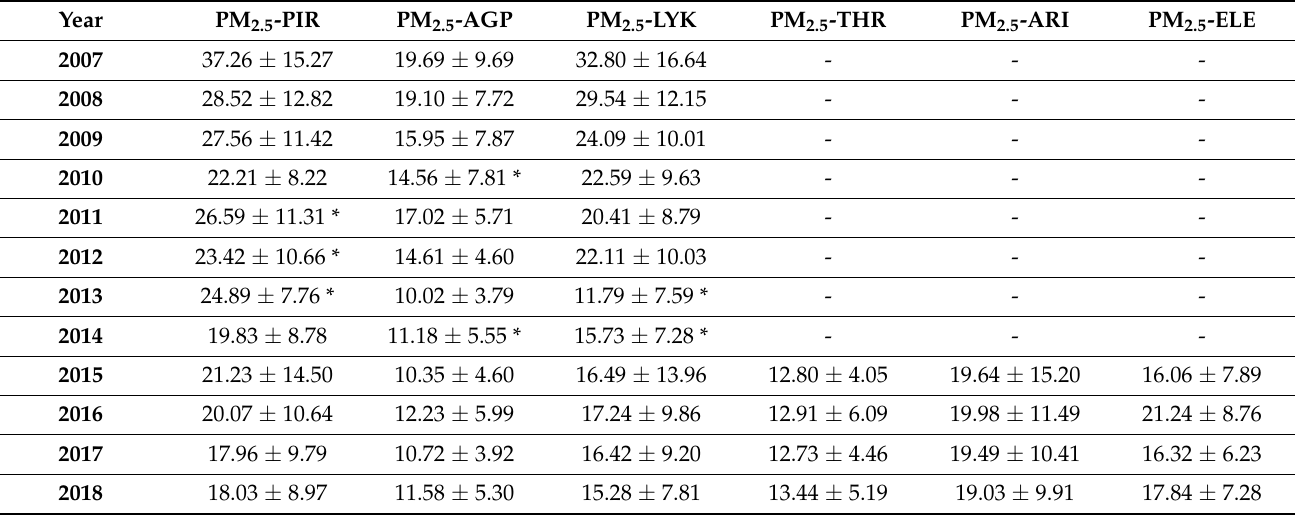
Table 3. The annual average values and standard deviations of the daily 24 h average concentrations of PM 2.5 at the six AQMS over the study periods (with (*) indicated the years with less than 59% of PM 2.5 data